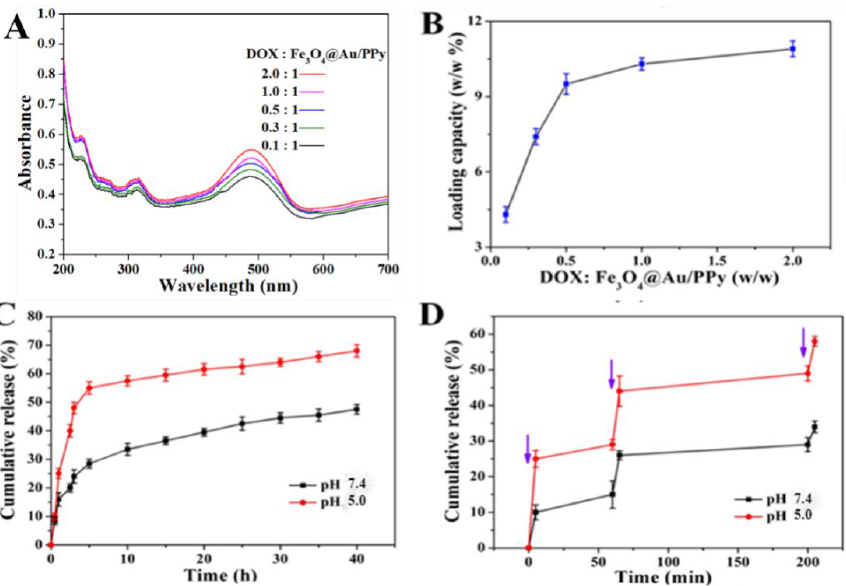
Figure 4. ( A ) UV-Vis absorption spectra of Fe 3 O 4 @Au/PPy-DOX dispersions with different weight ratios of DOX to Fe 3 O 4 @Au/PPy. ( B ) Quantitative analysis of DOX loading at different weight ratios of DOX to Fe 3 O 4 @Au/PPy. ( C ) In vitro drug release behavior of Fe 3 O 4 @Au/PPy-DOX in PBS at pH 7.4 and 5.0. ( D ) In vitro cumulative drug release from Fe 3 O 4 @Au/PPy-DOX. The samples at pH 7.4 and 5.0 were irradiated with a NIR laser (1 W/cm 2 ) for 5 min at different time points indicated by the violet arrows. The weight ratio of DOX to Fe 3 O 4 @Au/PPy is 2.0:1 in Figure 5A,B. Based on the excellent properties of the Fe 3 O 4 @Au/PPy-DOX nanoplatform, it was expected to become a novel anticancer agent. The relative viability of HeLa cells and different concentrations of Fe 3 O 4 @PPy, Fe 3 O 4 @Au/PPy and Fe 3 O 4 @Au/PPy-DOX after incubation under and without laser irradiation were measured by the MTT method. As expected from Figure 5A, Fe 3 O 4 @PPy and Fe 3 O 4 @Au/PPy exhibited a negligible cytotoxicity, even at 1 mg/mL. The co-presence of Fe 3 O 4 @Au/PPy and 808 nm laser irradiation reduced cell viability, suggesting that the generated heat and ROS of Fe 3 O 4 @Au/PPy under the NIR laser irradiation could efficiently kill tumor cells (Figure 5B). In contrast, with the laser irradiation, the viability of cells incubated with Fe 3 O 4 @Au/PPy-DOX was lower (35%), indicating the synergetic anticancer effect from Fe 3 O 4 @Au/PPy as well as the anticancer drug